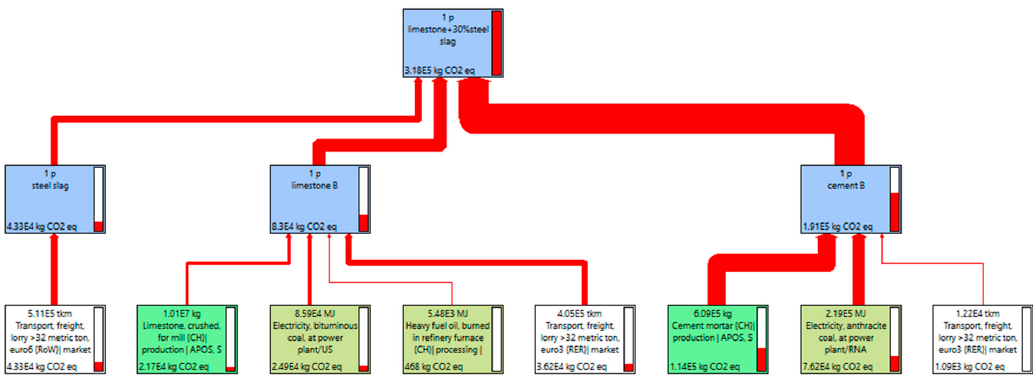
Figure 17. CO 2eq emission of 30% steel slag + 70% limestone with transport distance 100 km.